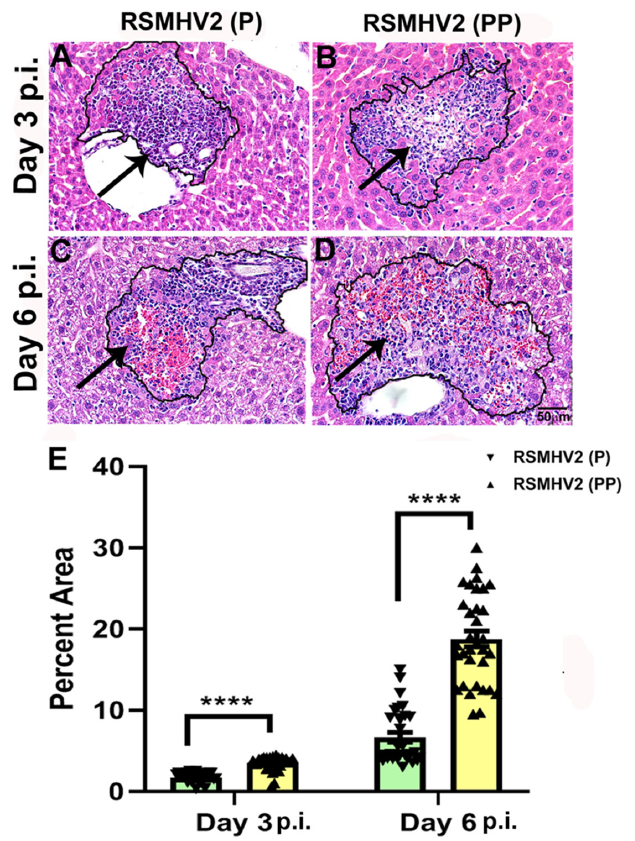
RSMHV2 (PP) infection . Five-micron thin liver sections of day 3 and day 6 post-infected mice were